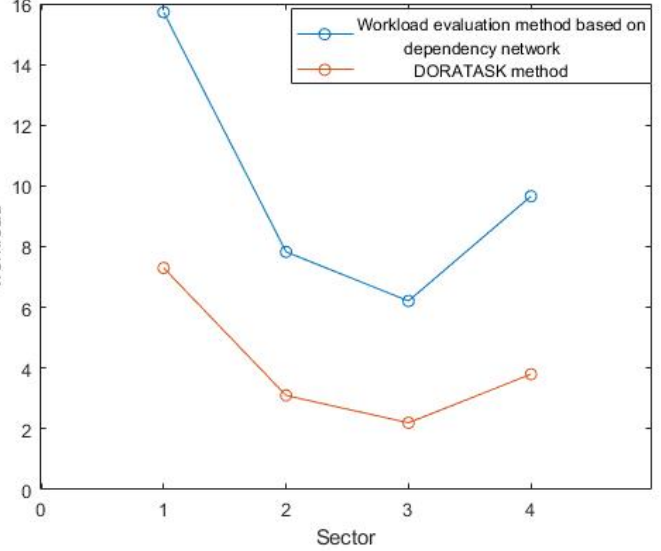
Figure 14. Comparison of the results of different controller load evaluation